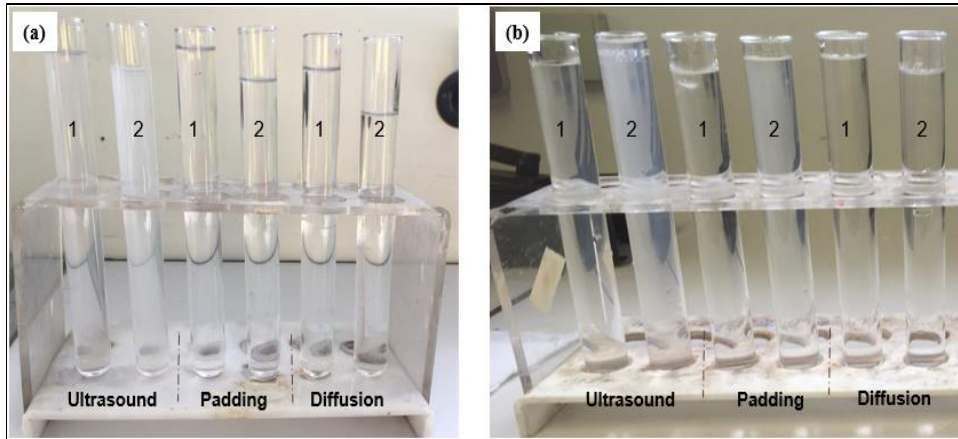
Figure 11. Change on the turbidity of different washing residue for different treatment methods ( a ) after the 1st washing and ( b ) after the third washing cycle, 1: P — PET — G and 2: CO — G. ( a ) after the 1st washing and ( b ) after the third washing cycle, 1: P—PET—G and 2: